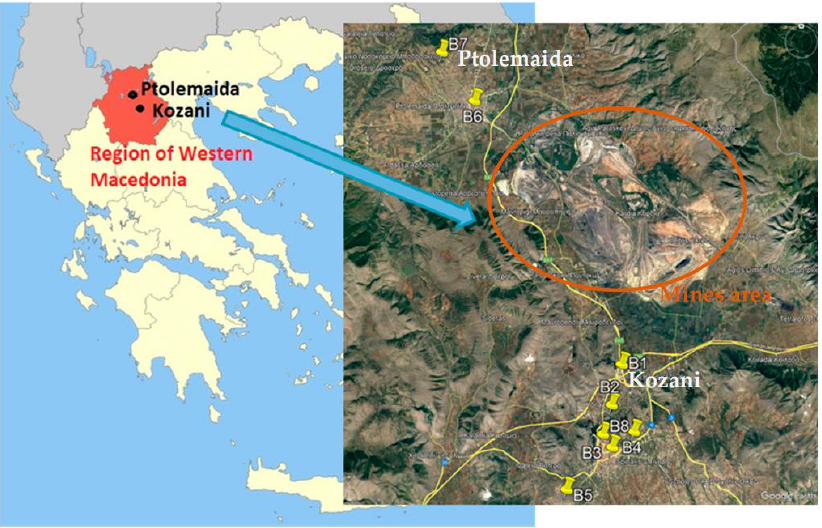
Figure 1. Location of the investigated office buildings at Kozani (40°18 ’ 2.48 ″ N 21°47 ’ 20.26 ″ E) and in Ptolemaida (40°30 ’ 23.99 ″ N 21°40 ’ 24.59 ″ E). in Ptolemaida (40 ◦ 30 (cid:48) 23.99” N 21 ◦ 40 (cid:48) 24.59”